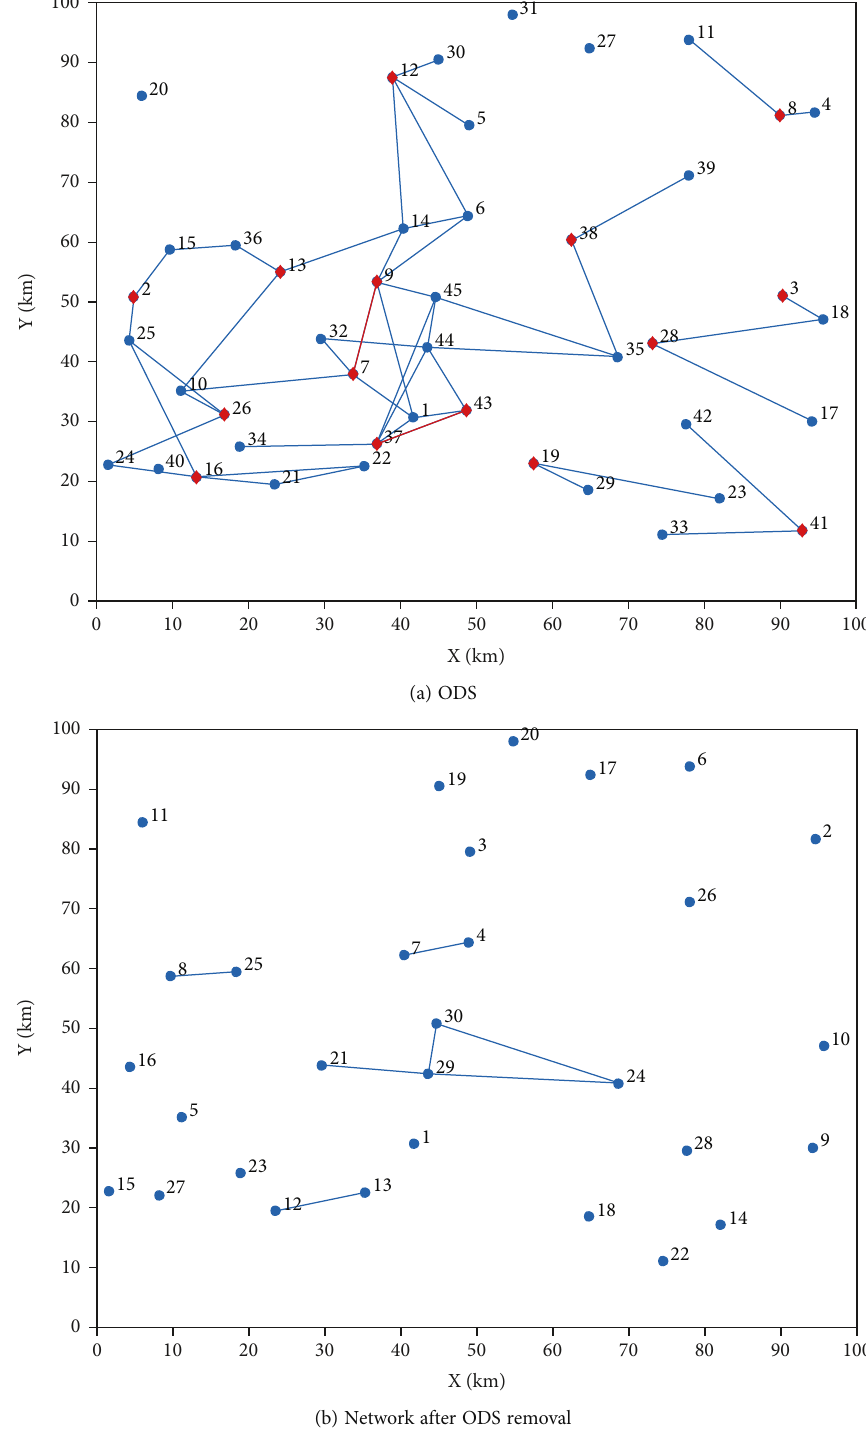
(b) Network after ODS removal Figure 15: Removes the ODS from the